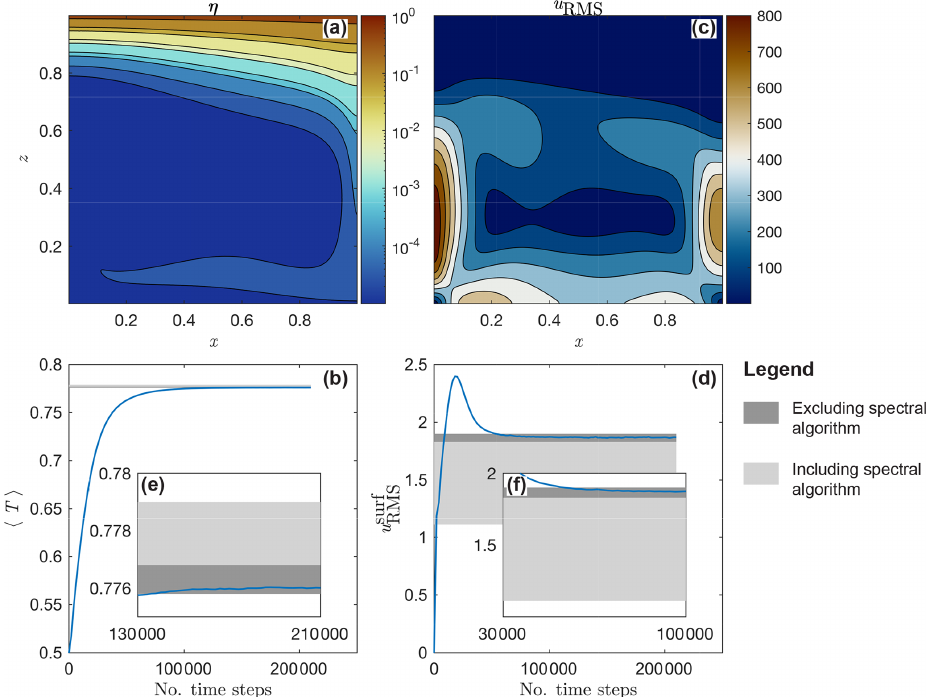
Figure C1. Results of 2D convection benchmark. (a) Effective viscosity after convection reached a steady state, (b) normal average temper- ature calculated as in Eq. (C6) for the entire model history, (c) root mean square velocity field for the entire domain after convection reached a steady state, (d) root mean square velocity at the surface of the modelled domain of the entire model history calculated as in Eq. (C7), (e) normal average temperature calculated as in Eq. (C6) for the time period at which the convection reaches a steady state and (f) root mean square velocity at the surface of the modelled domain calculated as in Eq. (C7) for the time period at which the convection reaches a steady state. In Fig. C1b and C1d–f, the dark grey area only shows the range of minimum and maximum values for the given diagnostic quantity obtained by the algorithms tested by Tosi et al. (2015) excluding the spectral algorithm. Dark combined with light grey areas indicate the range obtained by all algorithms tested by Tosi et al. (2015) including the spectral